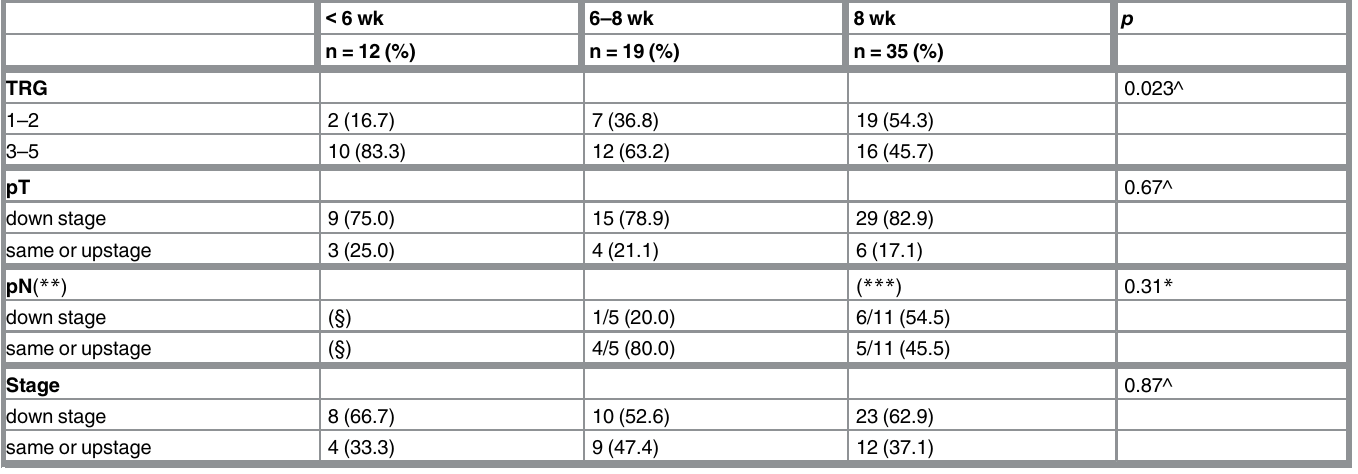
Table 3. Observed outcomes by interval to